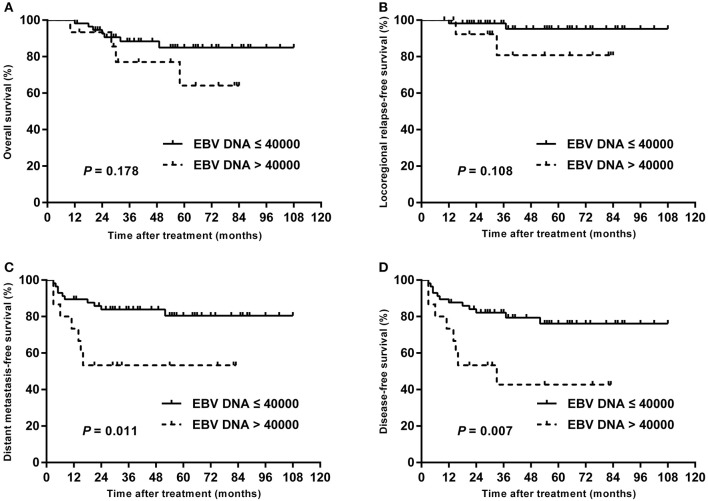
Kaplan–Meier estimate of the OS (A), LRRFS (B), DMFS (C), and DFS (D) of T4 children and adolescent NPC patients according to pretreatment EBV DNA levels.